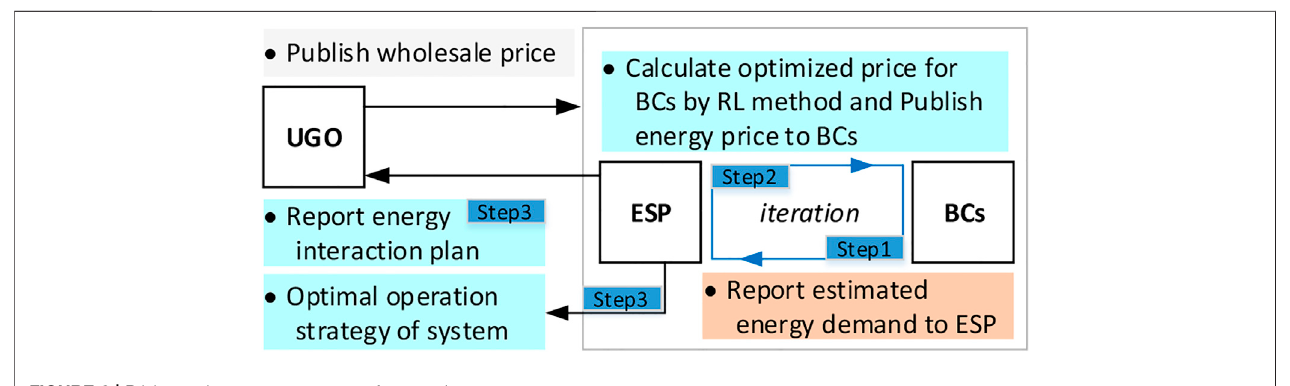
FIGURE 2 | Pricing and energy management